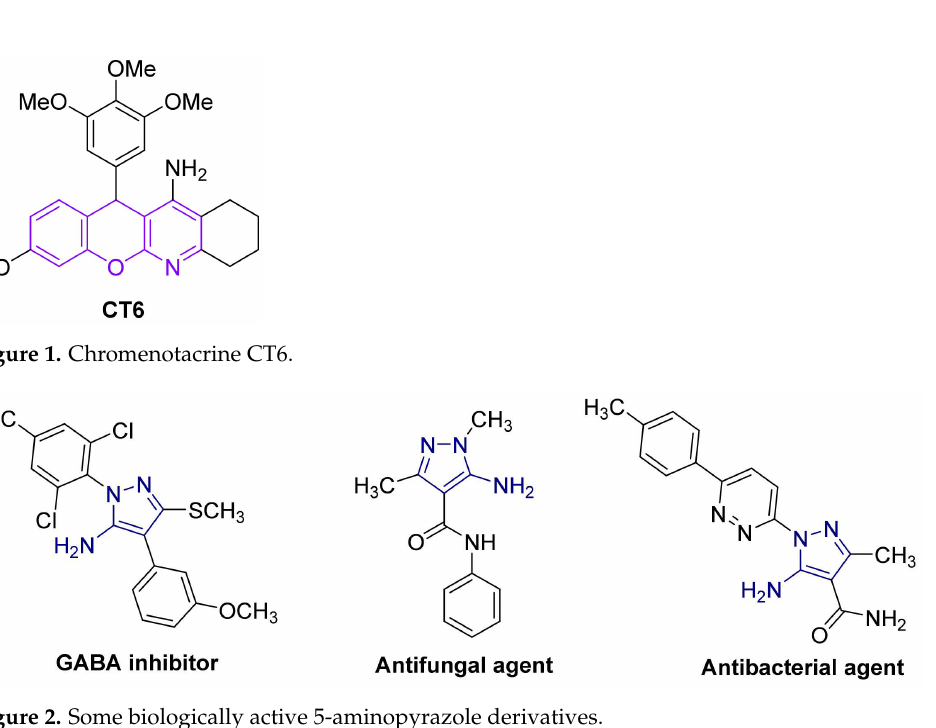
Figure 2. Some biologically active 5-aminopyrazole